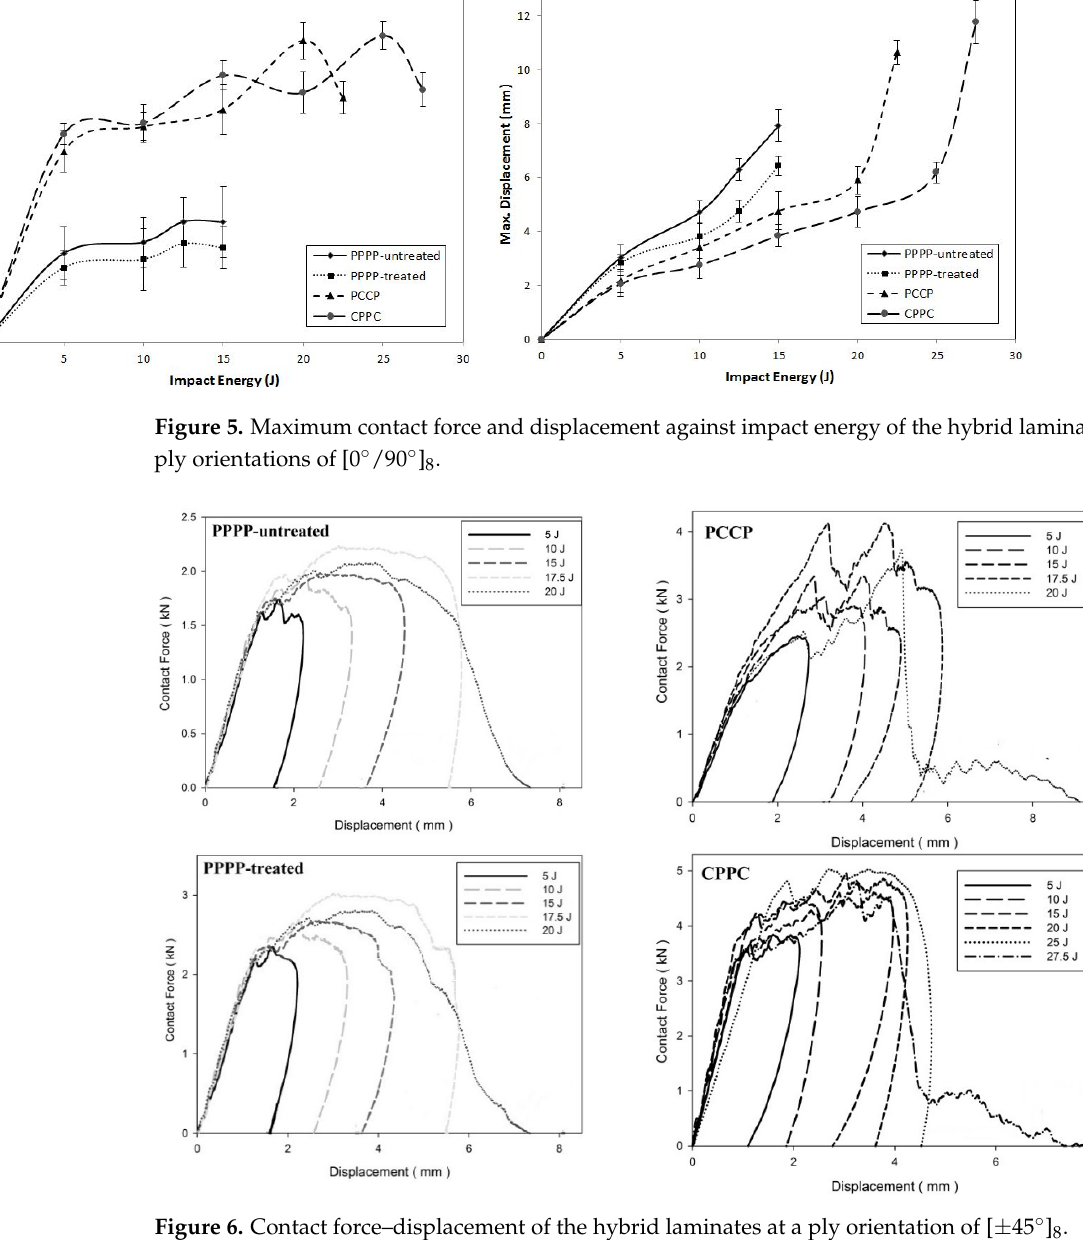
Figure 6. Contact force–displacement of the hybrid laminates at a ply orientation of [±45°] 8 .